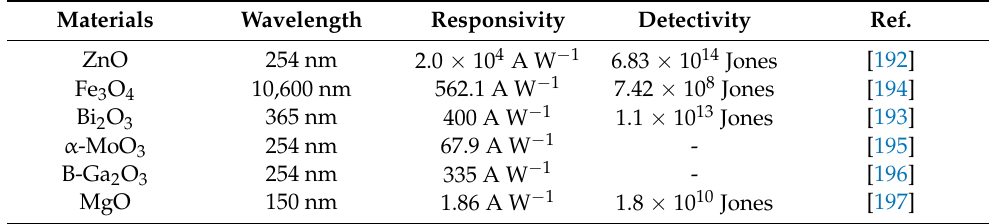
Table 4. Photodetectors based on 2D metal